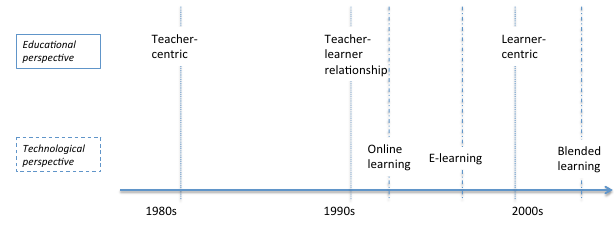
Figure 1. Evolution of the learning paradigm: